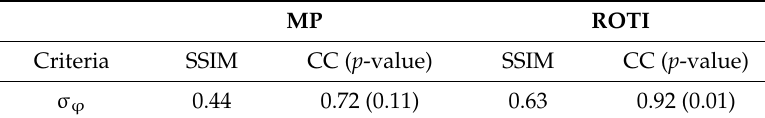
Table 20. SSIM and CC between the maps shown in Figure 16c.